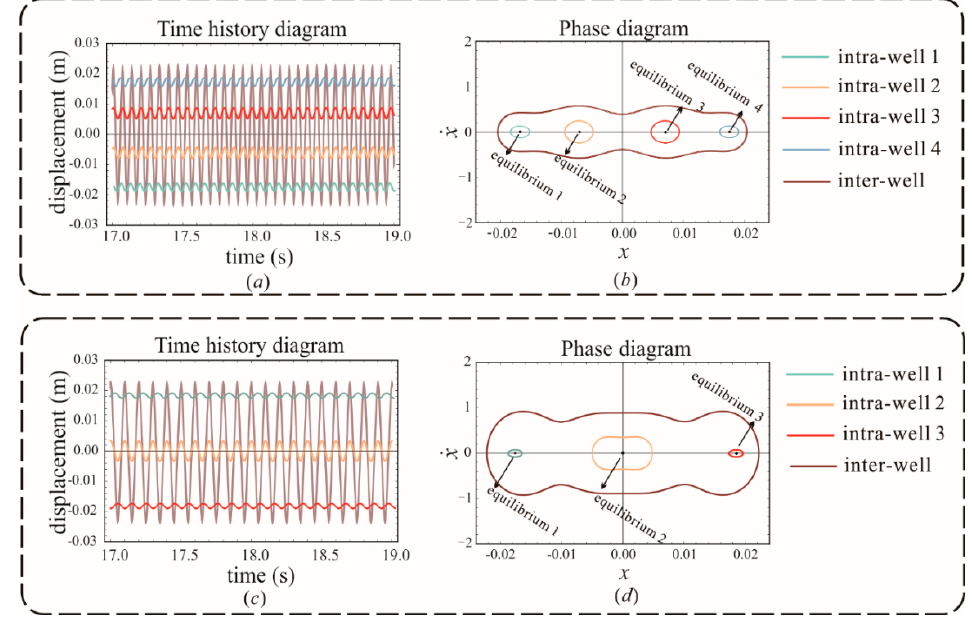
Figure 4. Time history and phase diagram of the ( a , b ) quad ‐ stable system and ( c , d ) tri ‐ stable system.